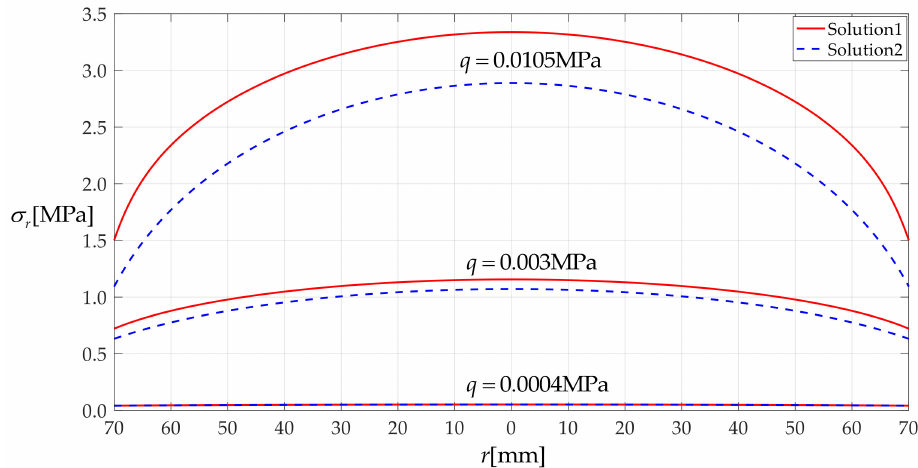
Figure 16. Variation of σ r with r when q takes 0.0004, 0.003, and 0.0105 MPa, respectively.